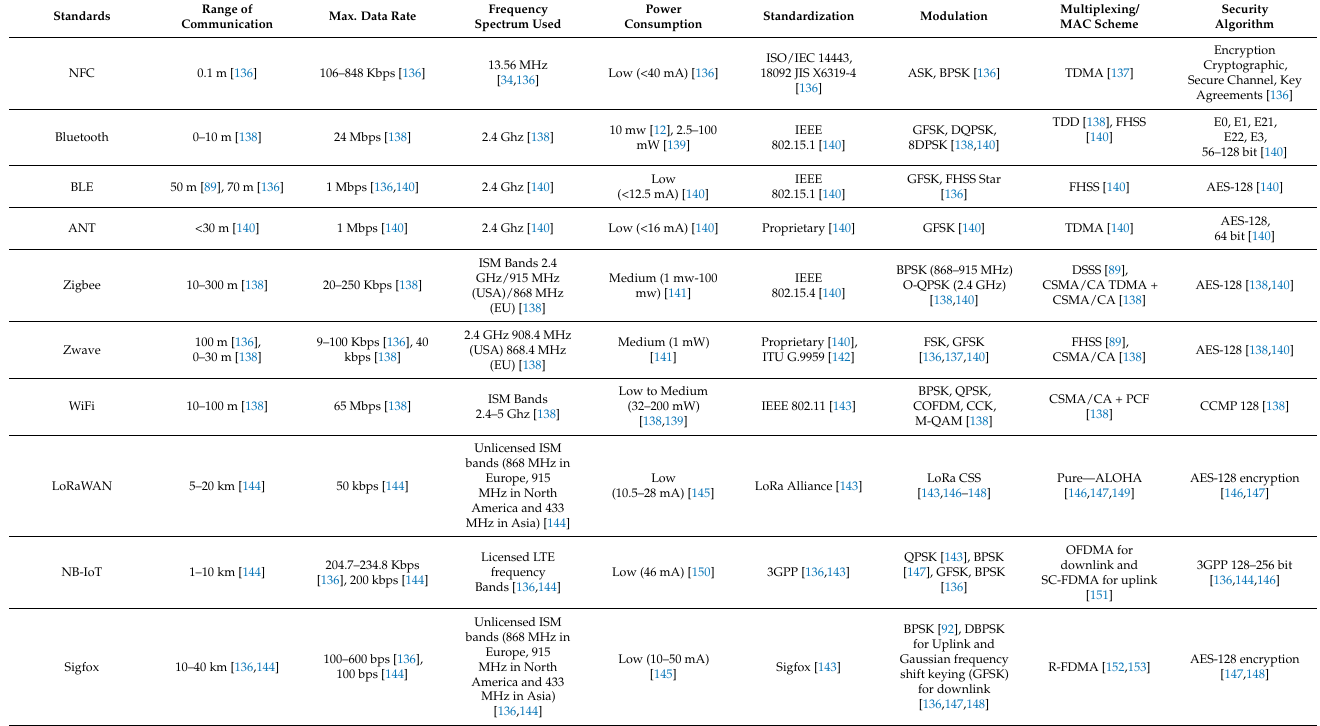
Figure 4. IoT Connectivity Standards. Table 4. Comparison of different IoT Connectivity Standards.